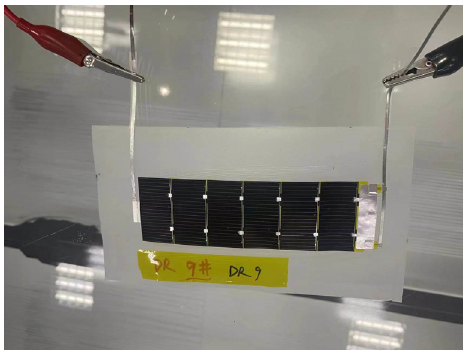
Figure 8. Test of single GaInP/GaAs/Ge cell.